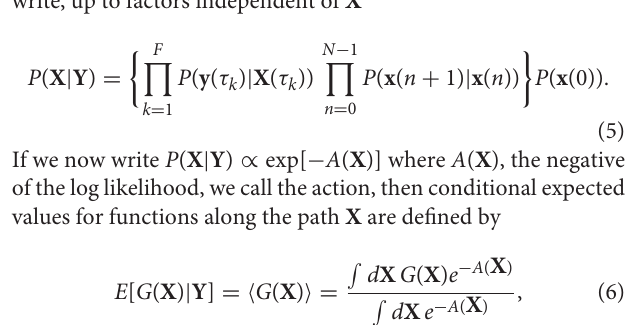
FIGURE 1 | A visual representation of the window t 0 t k τ k 1,..., F . This also shows times at which the D -dimensional model developed by the user x ( n = ; = n t 0 n 1 t n 1: t n 0,1,..., N . D + = + ; = y ( τ 1 ), y ( τ 2 ),..., y ( τ k ),..., y ( τ F observation time τ k , Y = {